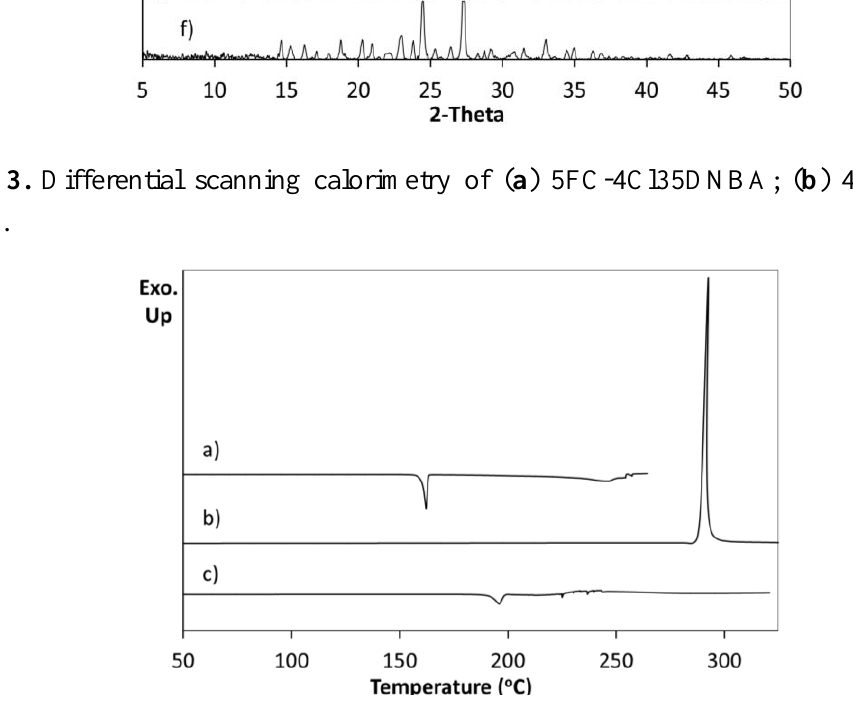
Figure 4. Asymmetric unit of CYT-4Cl35DNBA displaying the hydrogen bonding interactions of the deprotonated 4Cl35DNBA carboxylic acid group with the cytosine